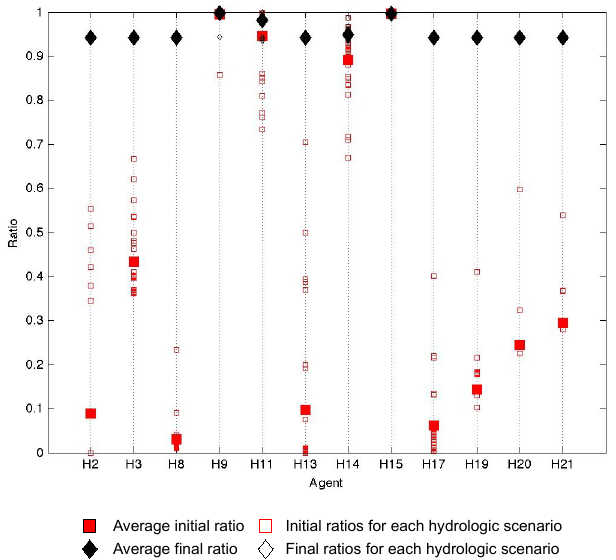
Figure 13. Initial and final ratios for hydropower agents.